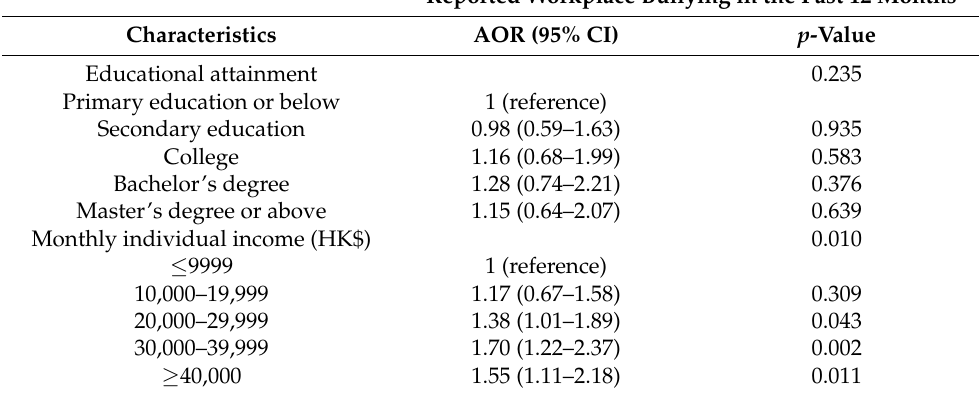
Table 3. Adjusted odds ratios (AOR) and 95% confidence intervals (95% CI) of workplace bullying in the past 12 months by risk factors. Reported Workplace Bullying in the Past 12 Months Characteristics AOR (95% CI) p